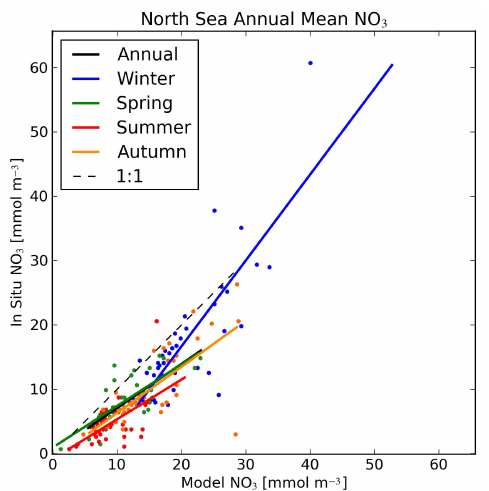
Fig. 9. Two-dimensional scatter plot of annual mean matched model data against in situ measurements for the North Sea phosphates. The solid coloured lines show the linear regression fits for the annual and seasonal annual means data, and the dashed line is the line of unity slope that passes through the origin. The matched seasonal means are shown as colour-coded scatter